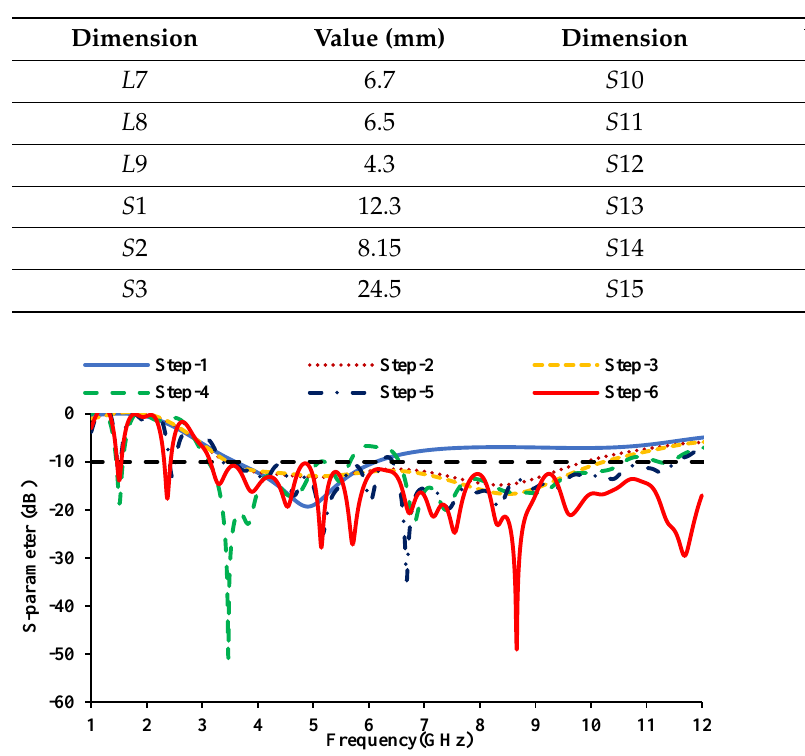
Figure 3. Reflection coefficients of the evolution steps.